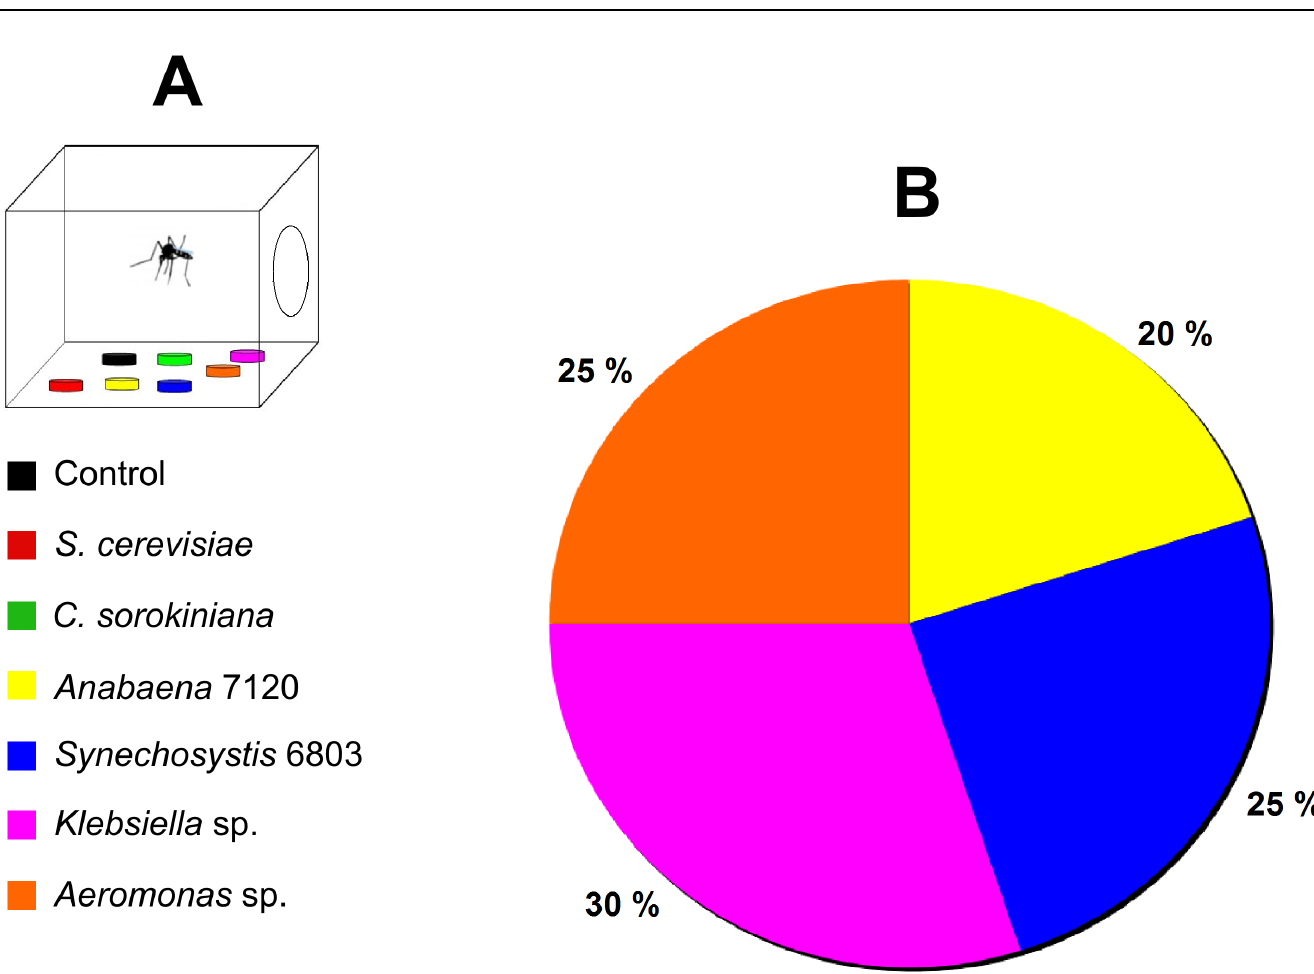
Fig 4. Oviposition substratum choice. (A) Diagram of oviposition preference assays with female mosquitoes. (B) Percentage (%) of oviposition substratum (microorganism) selected by gravid females. N eggs raft = 20.